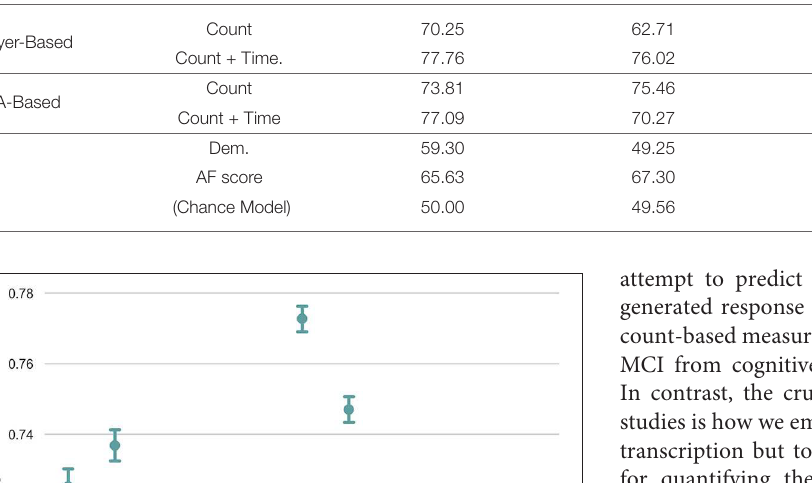
TABLE 3 | Classification results using selected features (mean over 500 leave-pair-out spatial cross-validation repeats). Method